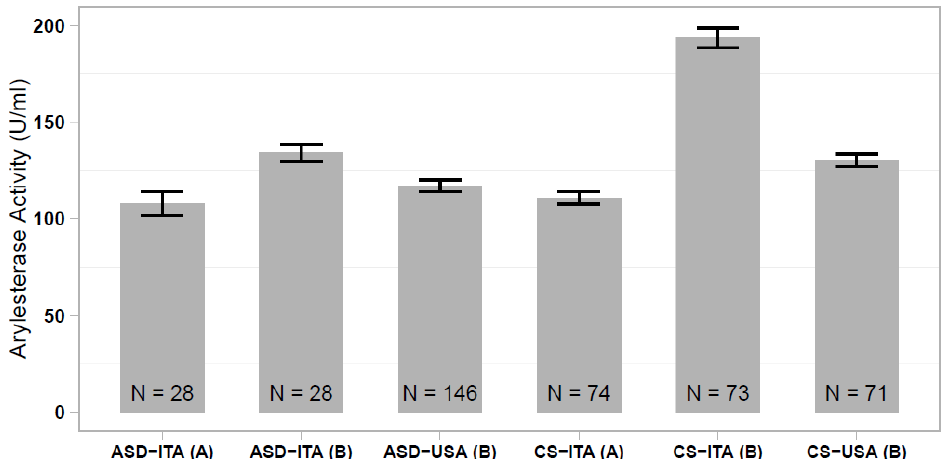
Figure 2. Comparison of serum arylesterase activity levels measured in ASD and control samples of Italian and Caucasian-American ethnicity, assessed ( A ) in the present work and ( B ) in the work of Gaita et al. (2010)